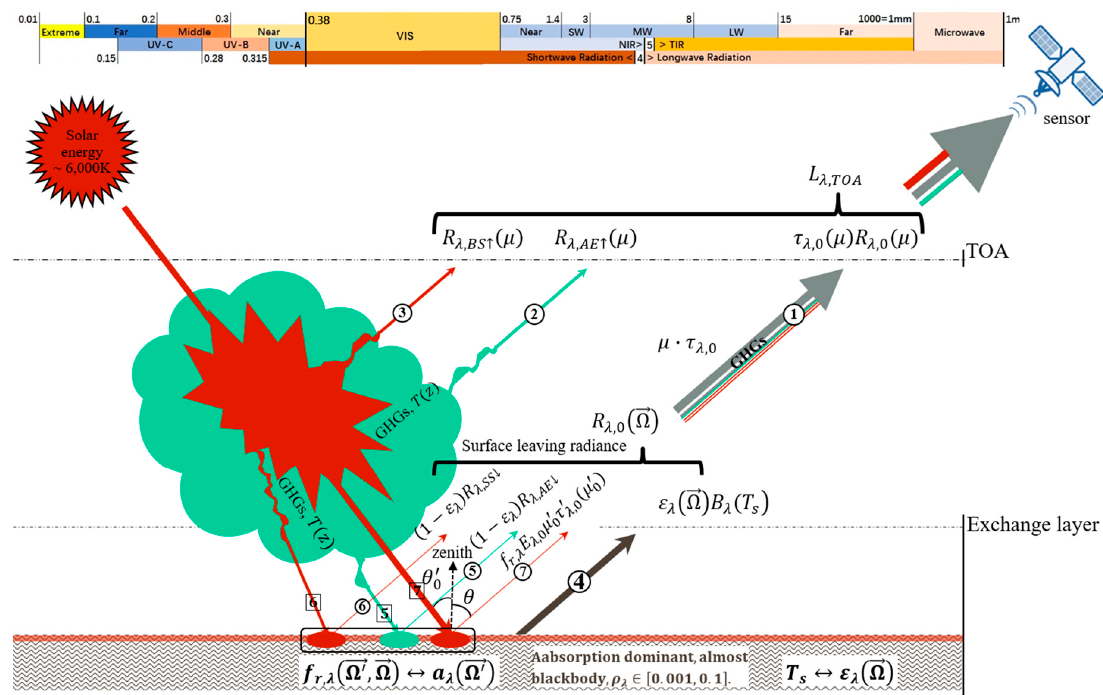
Figure 1. Summation of the surface temperature (ST) retrieval from spaceborne imegeries associated processes including the forward process of top of atmosphere (TOA) radiance simulation and the inverse of the TOA radiance for ST retrieval as well as the ST retrieval associated conceptions including the directional emissivity, the Kirchhoff’s law, the Mid-wavelength infrared Mid-wavelength infrared, and the atmospheric correction (see the context of this paper for the definitions of the symbols, notations and formulae).